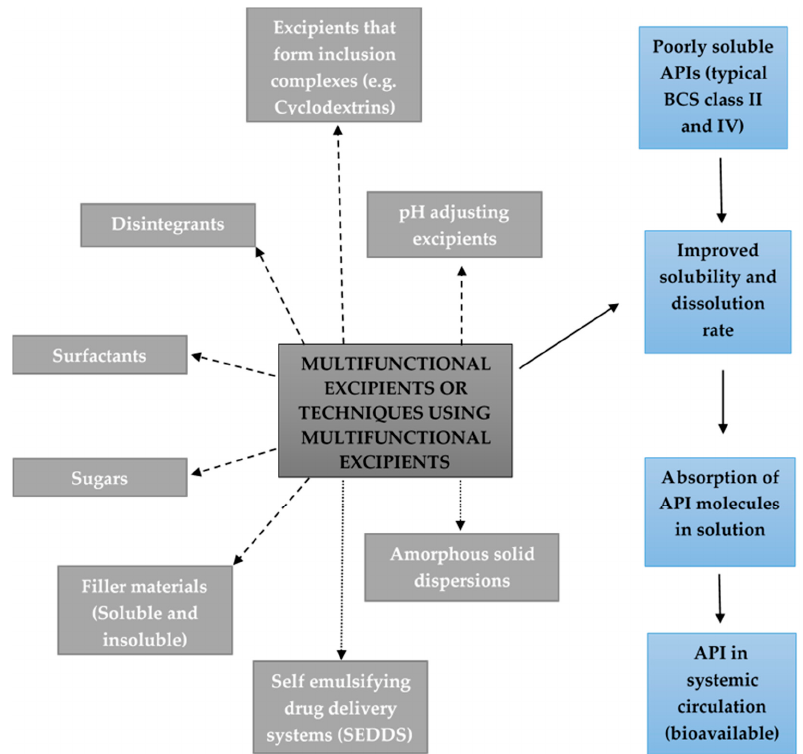
Figure 1 is a schematic representation of di ff erent classes of functional excipients and techniques using functional excipients that improve either the solubility / dissolution and / or membrane permeation / absorption and thereby also the bioavailability of poorly soluble APIs. Pharmaceutics 2020 , 12 , x